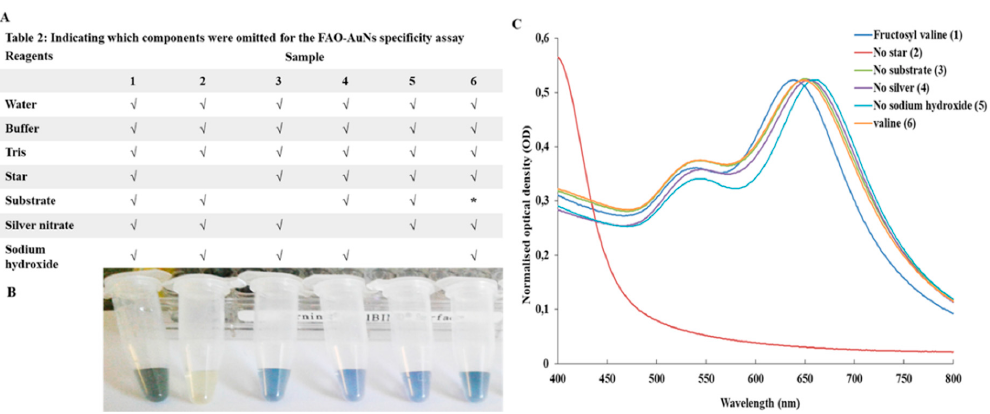
Figure 5. Specificity assay. ( A ) Table showing omitted reaction components accept for * which indicates the replacement of fructosyl valine with L-valine. ( B ) Photograph of the colours obtained for the reaction as laid out in the table. ( C ) Corresponding normalised UV-Vis spectra.